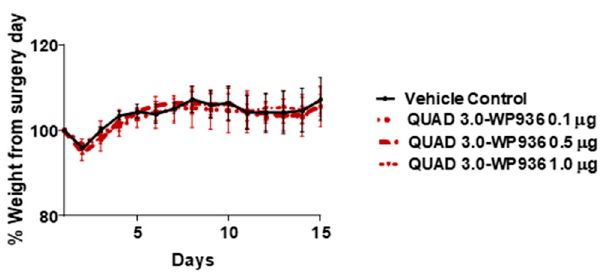
Figure 7. QUAD 3.0-WPD936 is safe in mice. Change in weight (%) of C57BL/6 mice after intracranial injections of QUAD 3.0-WP936.